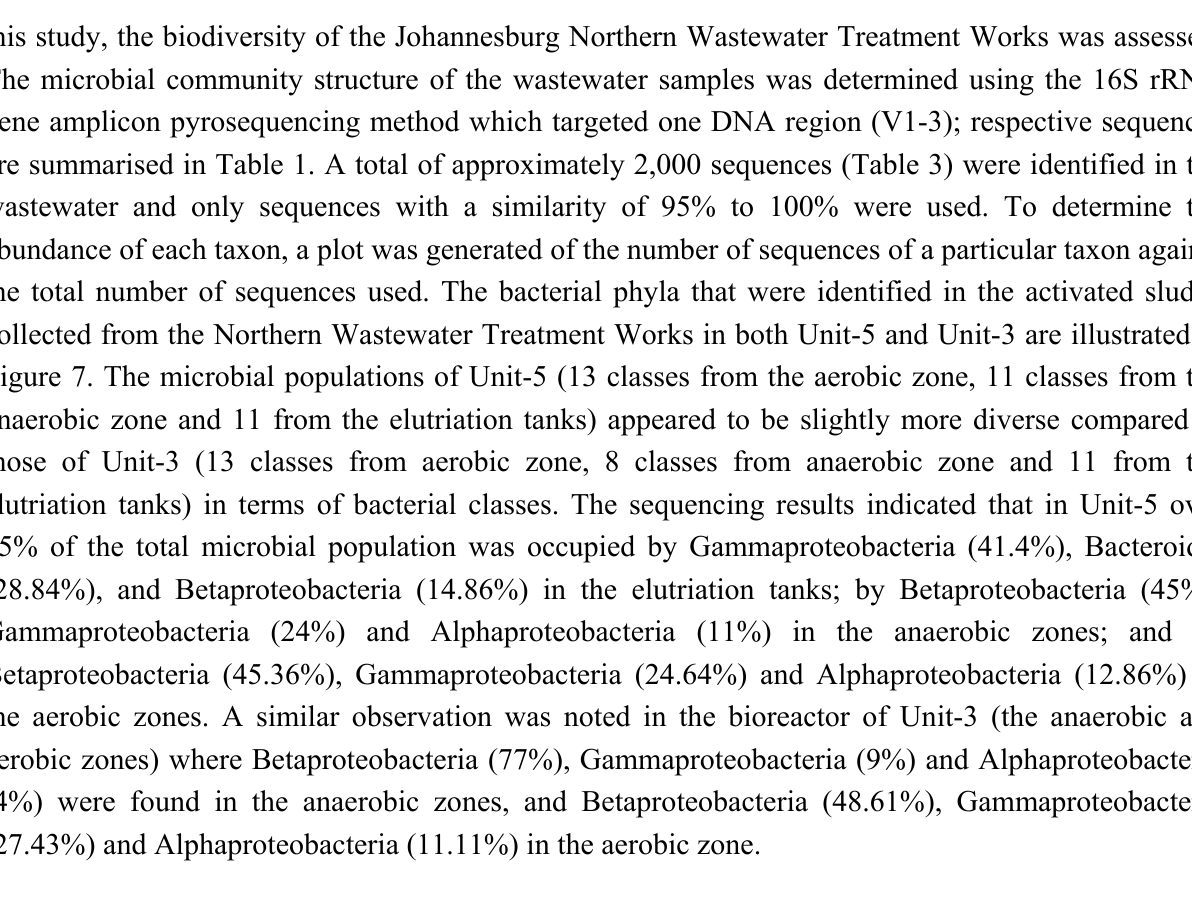
Figure 7. Microbial diversity (by phylum) of the Northern Wastewater Treatment Works (Unit-3 and Unit-5), Johannesburg, South